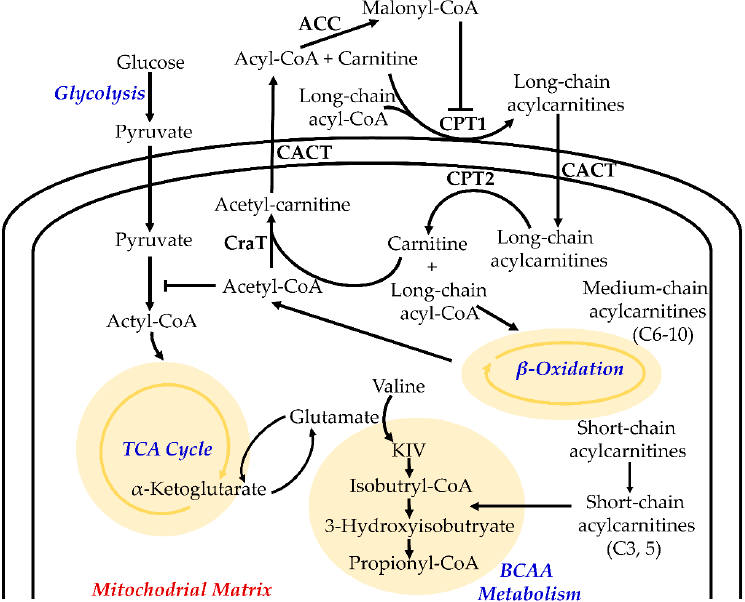
Figure 2. Overview of acylcarnitine-related cellular metabolism. For simplicity, not all intermediates and reversible processes are shown. Abbreviations: CPT1, carnitine-palmitoyl-transferase 1; CPT2, carnitine-palmitoyl-transferase 2; CACT, carnitine-acylcarnitine-translocase; CoA, coenzyme A; LACS, long-chain acyl-CoA synthetase; BCAA, branched-chain amino acid.